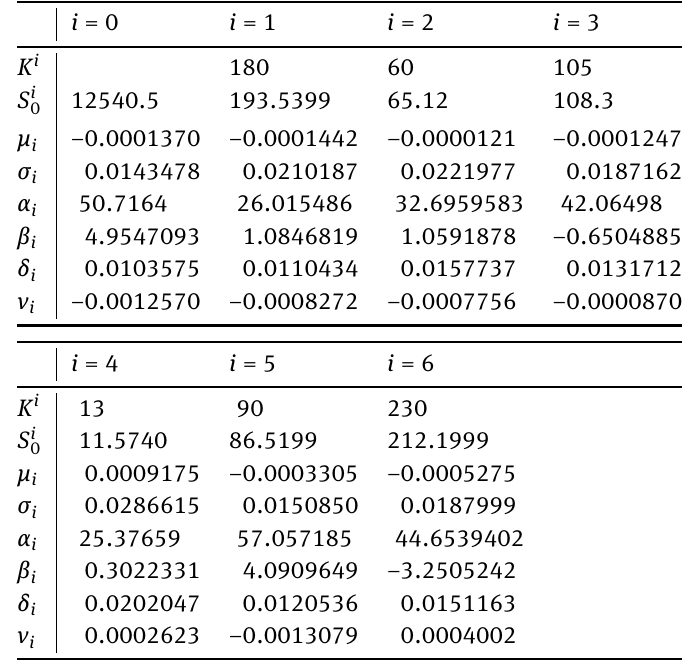
Table 1: Strikes K i (chosen), initial values S i 0 = s i 2540 (observed) and parameters µ i , σ i , α i , β i , δ i , ν i describing the daily ) (1a) resp. (1b) (estimated). log-increments of ( S i t under Assumption t